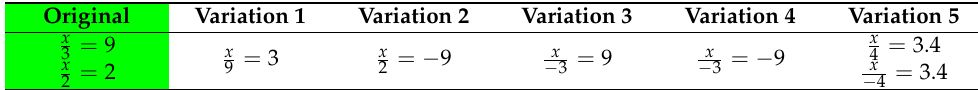
Table 6. Examples of type 5 equations and